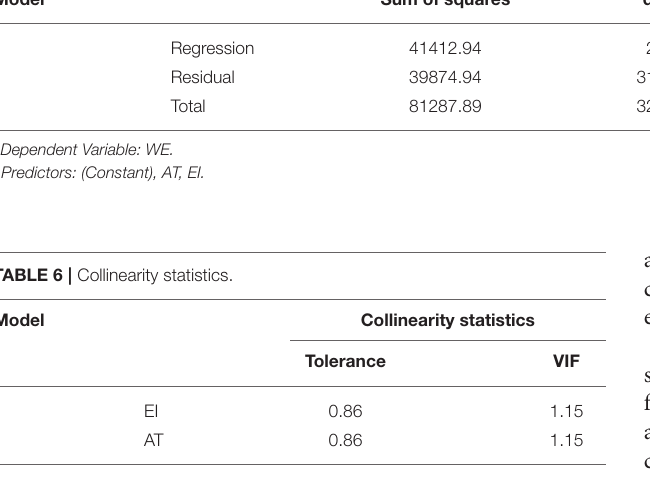
TABLE 5 | ANOVA for work engagement, emotional intelligence, and ambiguity tolerance. Model